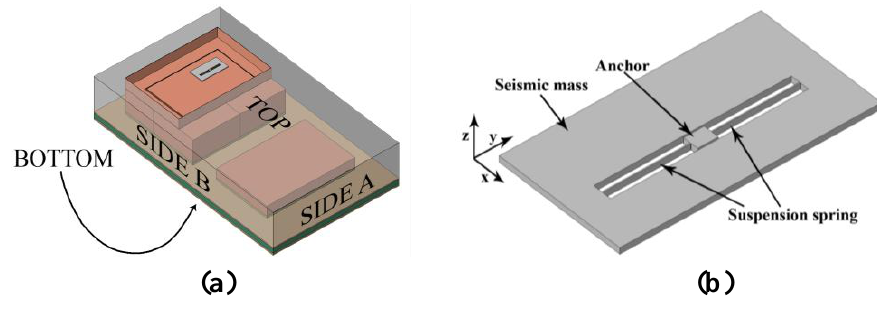
Figure 7. Sketch of the studied device: (a) macro-scale model of the whole package; (b) meso-scale model of the uniaxial MEMS